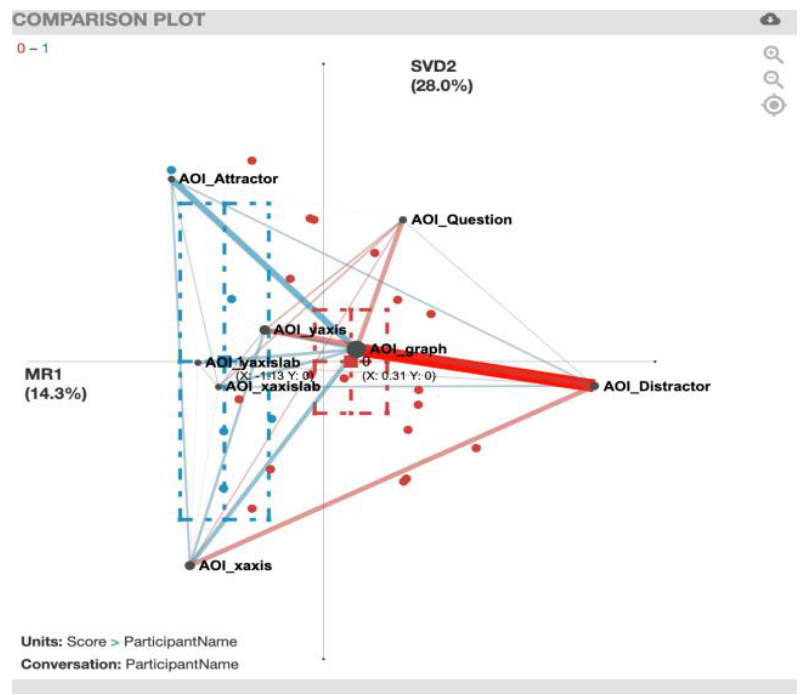
Sensors 2020 , 20 , x 23 of 32